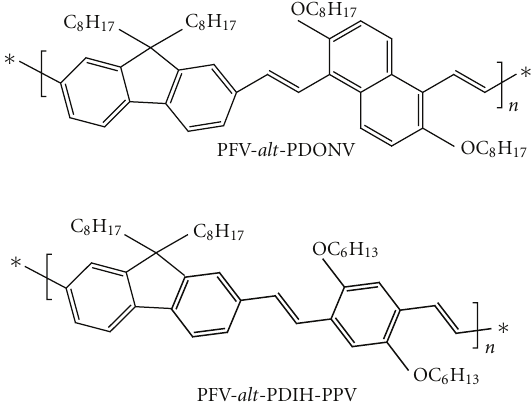
Figure 1: Conjugated polymers for theoretical